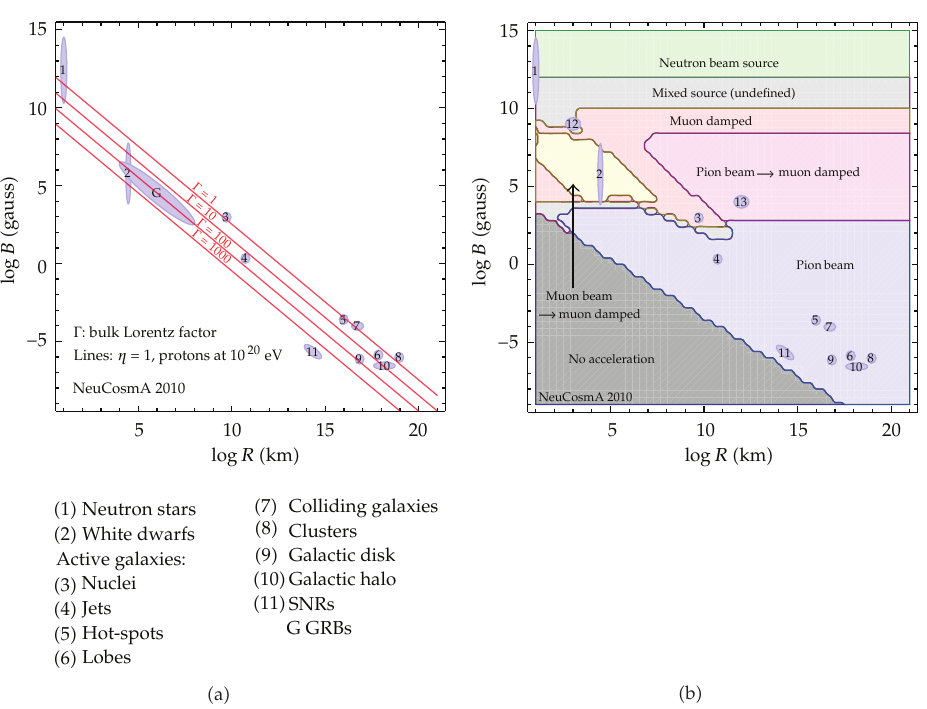
Figure 10: (cid:3) a (cid:4) Possible acceleration sites in Hillas plot as a function of R and B (cid:3) version adopted from M. Boratav (cid:4) . (cid:3) b (cid:4) Classification of sources for injection index α (cid:10) 2 in this plot (cid:3) see main text (cid:4) . Some points from left plot are shown for orientation, as well as two new points (cid:3) 12 and 13 (cid:4) , figure taken from (cid:5) 34 (cid:6)